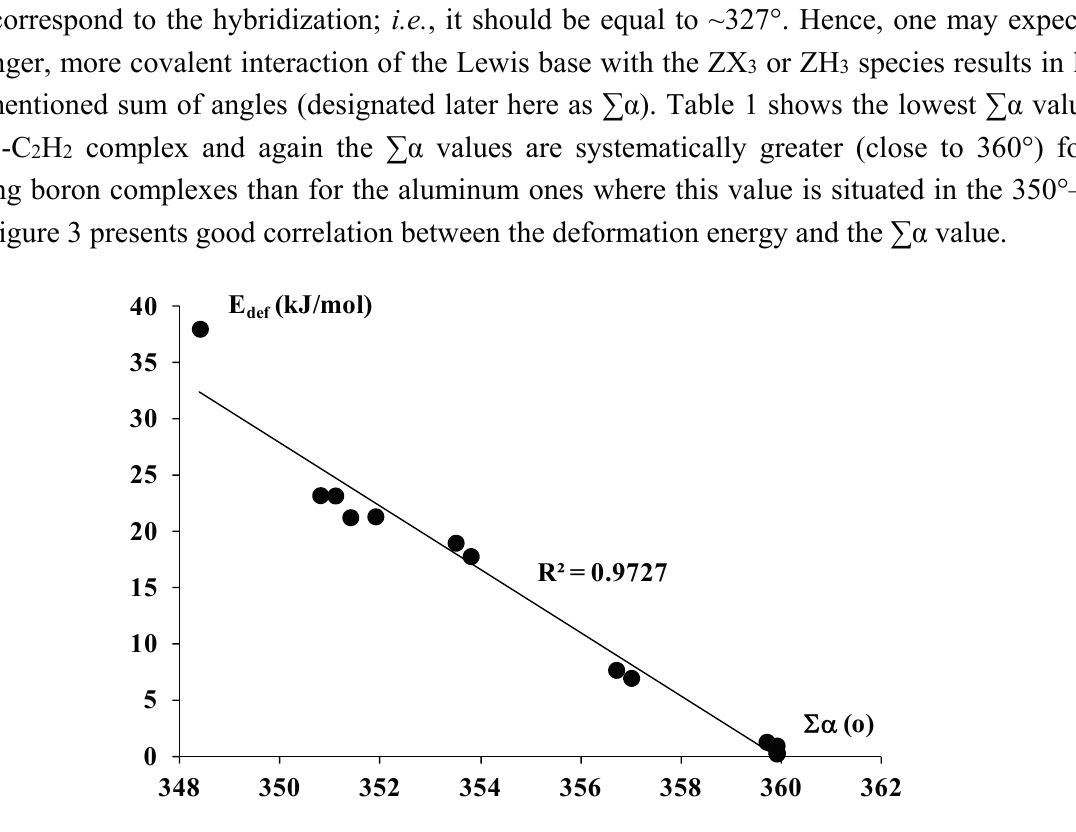
Figure 3. The linear correlation between the ∑α parameter (in degrees) and the deformation energy (in